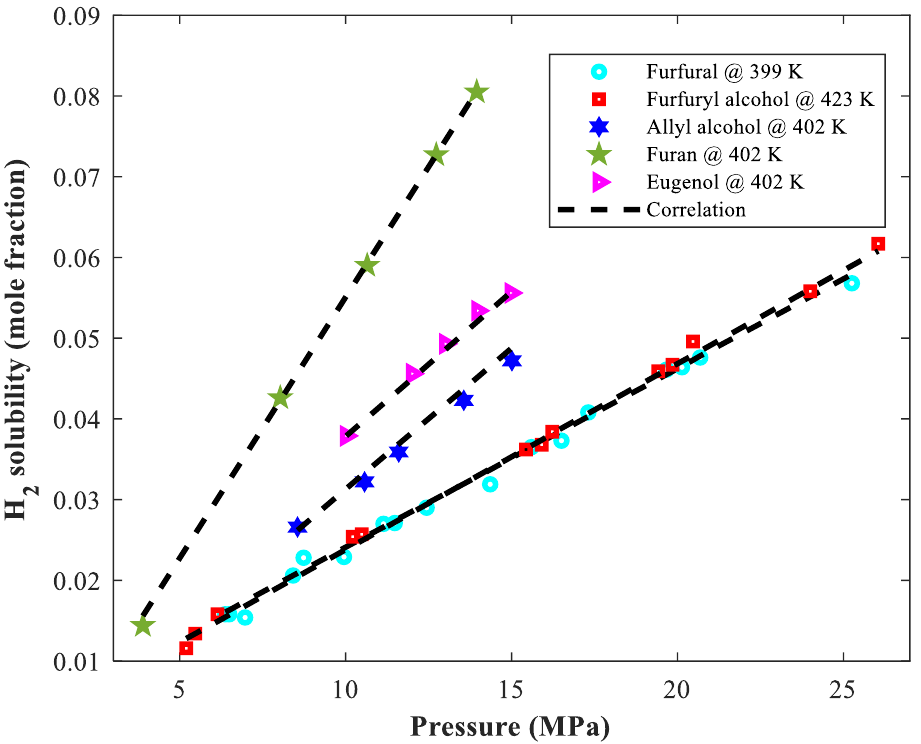
Figure 9. Actual and modeling results for comparing hydrogen dissolution ability of diverse bio- materials.